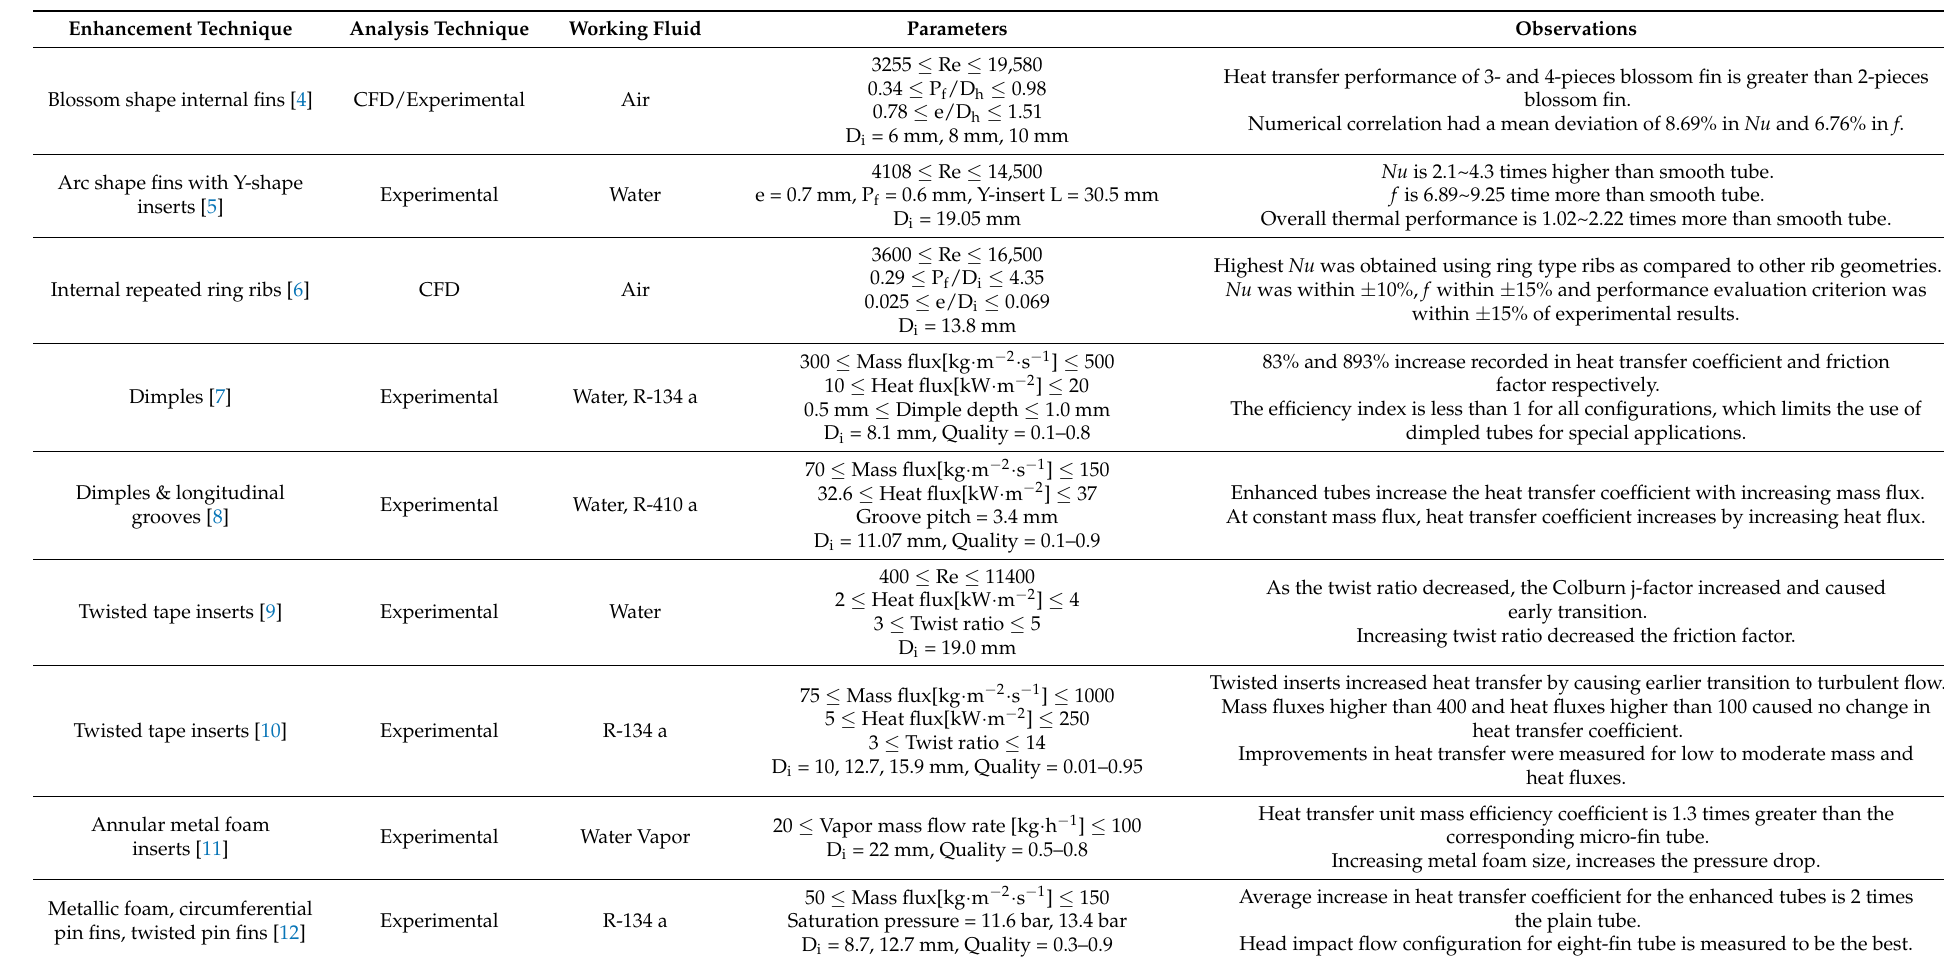
Table 1. Literature review of passive heat transfer enhancement